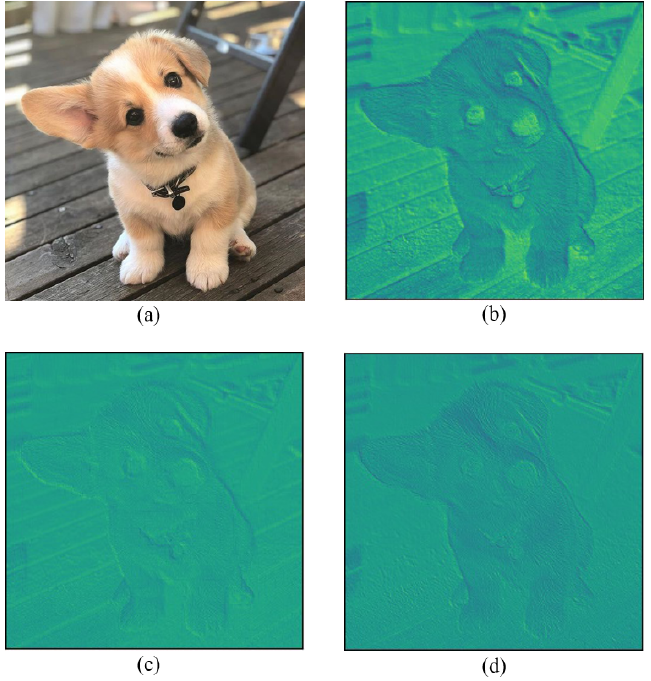
Figure 8. Feature map visualization: ( a ) input image; ( b ) feature map output by the convolution kernel with a size of 1 × 1; ( c ) feature map output by the convolution kernel with a size of 3 × 3; ( d ) feature map output by the convolution kernel with a size of 5 ×